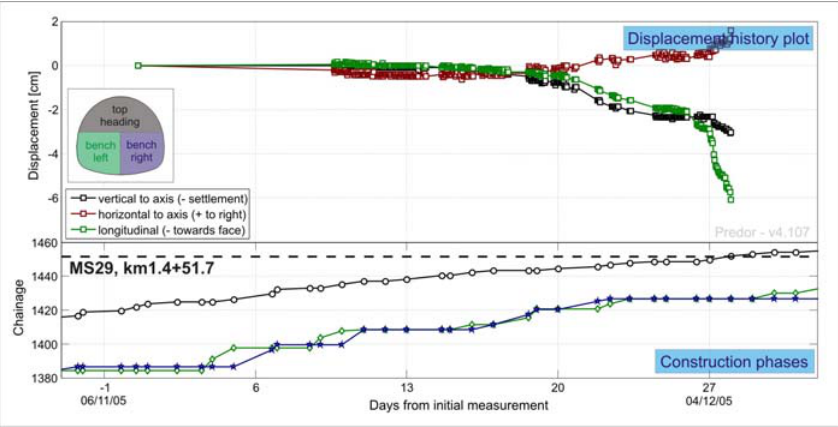
Figure 12. Spatial displacement history plot of the crown point in measuring cross section MS43 at chainage km 1.4+78.6 in the left tube of the exploratory tunnel.